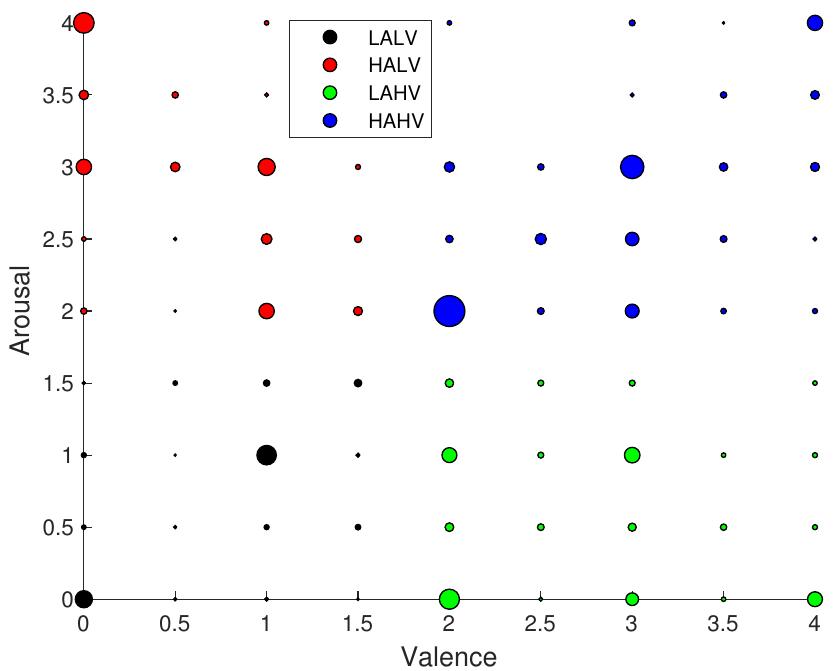
Figure 2. The responses from the research subjects were distributed according to an arousal and valence scale. Higher diameter circles indicate the higher sample frequency of a